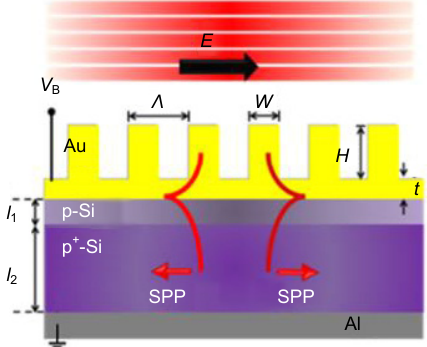
Fig. 6 | Schematic diagrams of plasmonic Schottky detectors. A gold patch on p-Si substrate with a gold grating on top . Figures reproduced from ref. 29 , Optical Society of